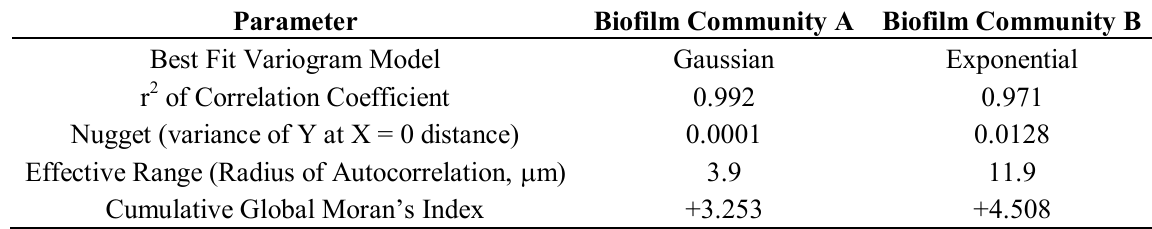
Table 9. Parameters of the best-fit geostatistical models derived from the isotropic variogram of the CMEIAS cluster index for microbial cells within biofilm assemblages of communities A and